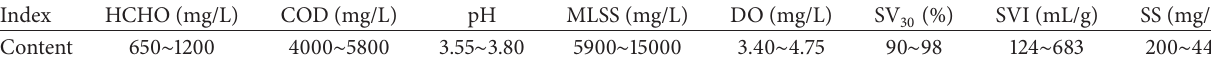
Figure 1: Process flow diagram in the field. Table 1: Flooding water quality and sludge properties in the field.